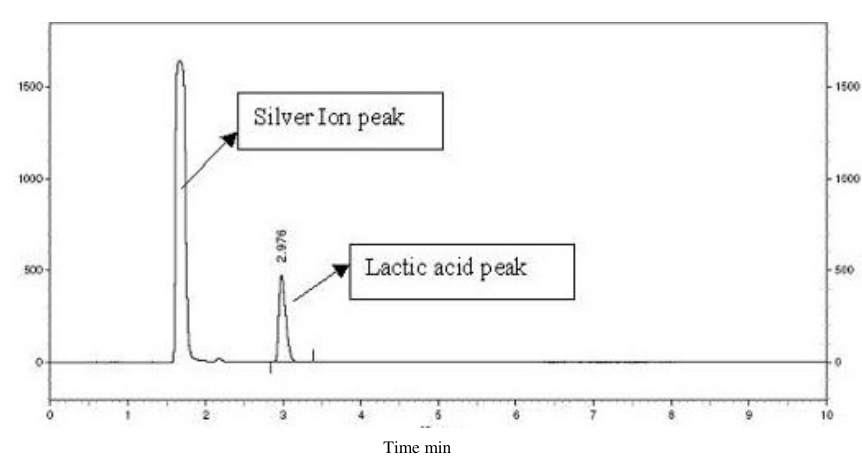
Figure 2 . Chromatogram showing resolution of silver ion and lactic